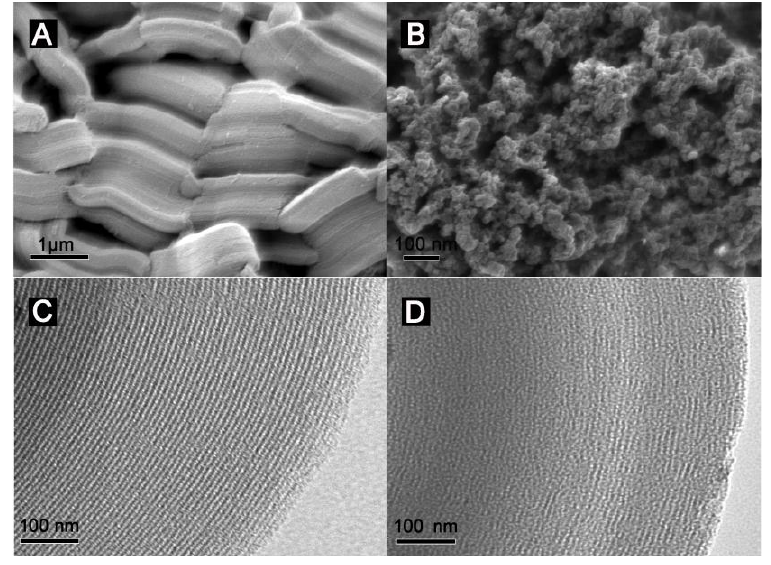
Figure 4. SEM images of ( A ) SBA-15 and ( B ) SBA-15@MT-MIPs; TEM images of ( C ) SBA-15 and ( D ) SBA-15@MT-MIPs.